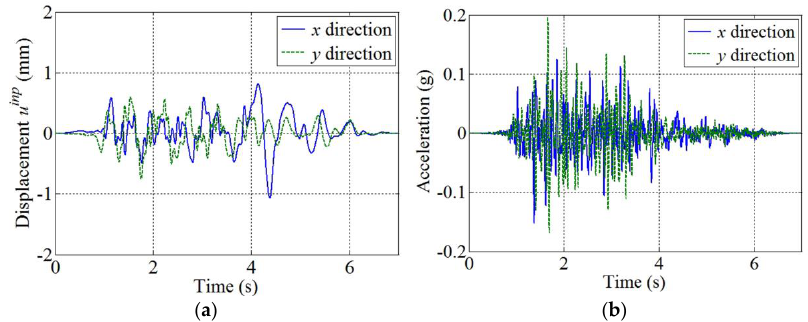
Figure 18. Low-intensity ground motions; ( a ) ground displacement; ( b ) ground acceleration.